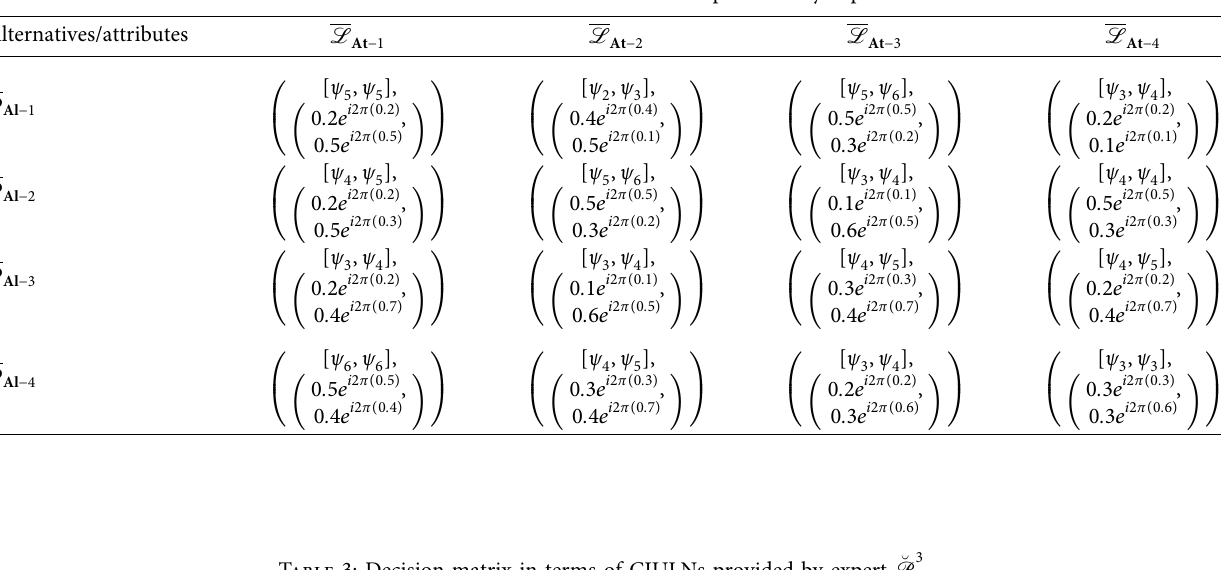
Table 2: Decision matrix in terms of CIULNs provided by expert � R 2 .